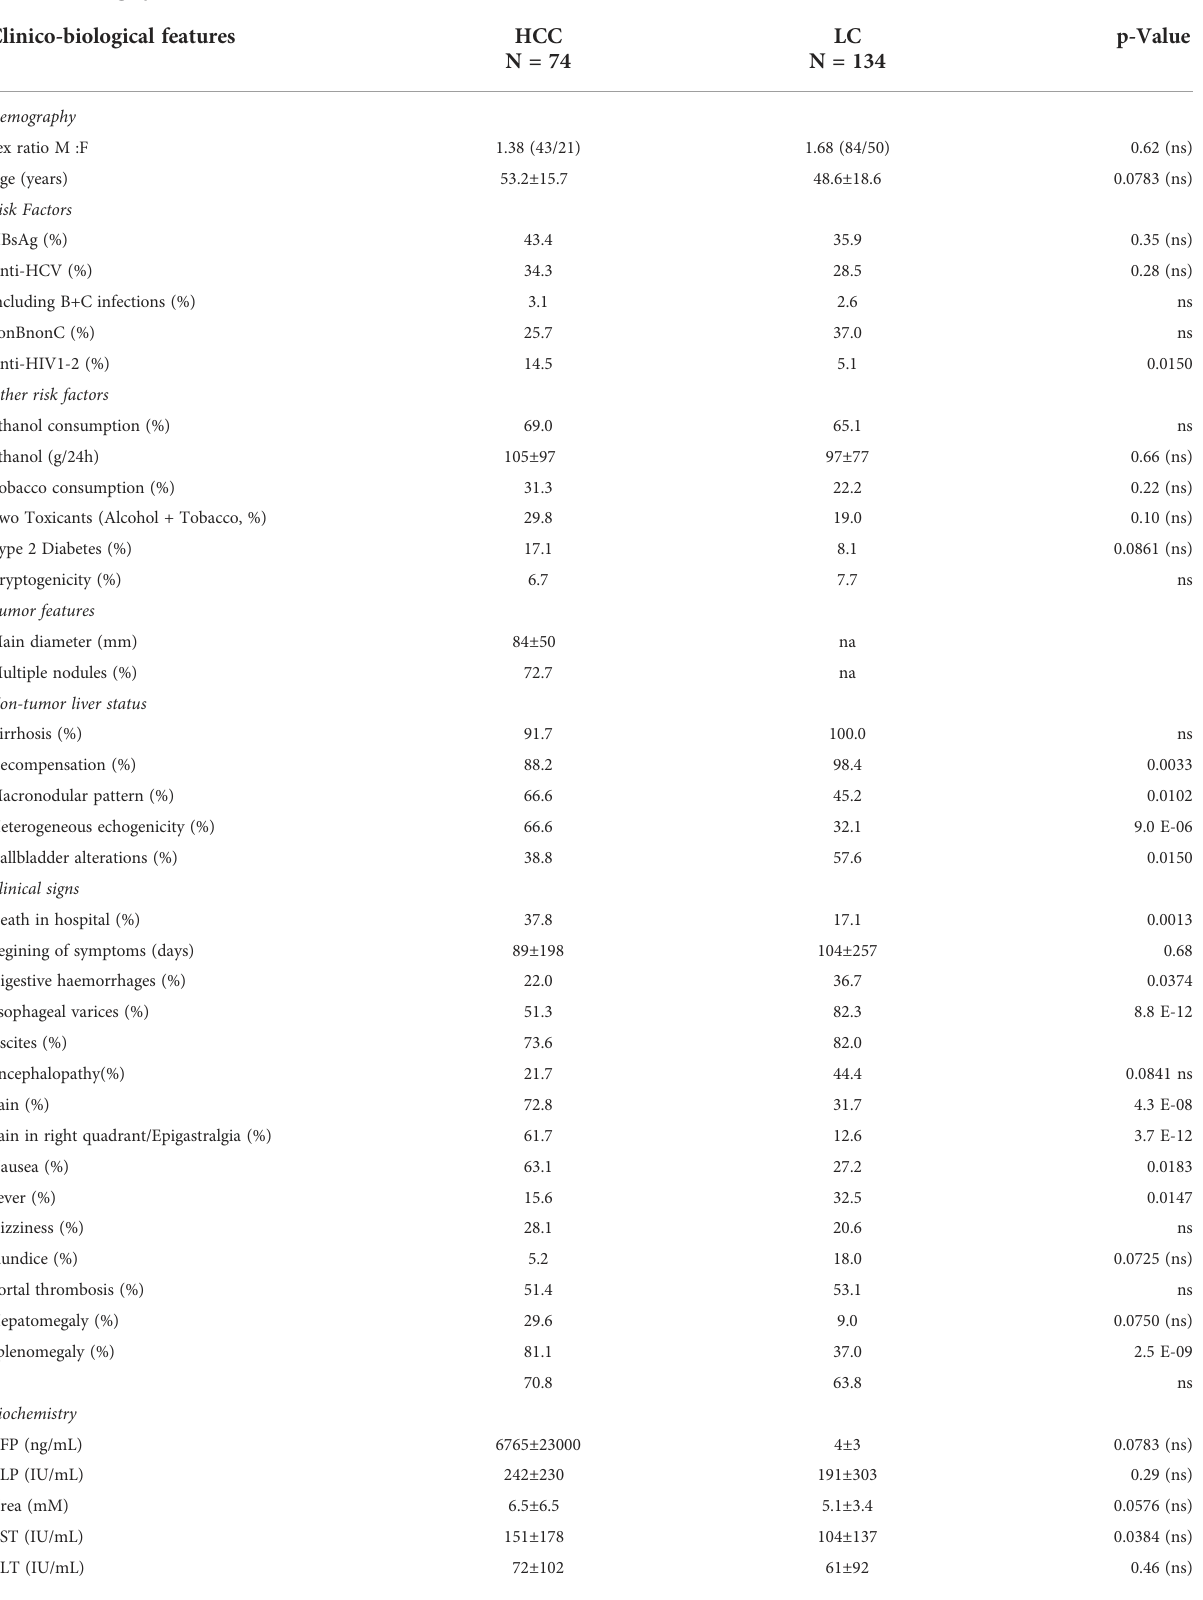
TABLE 1 Demographical and clinical